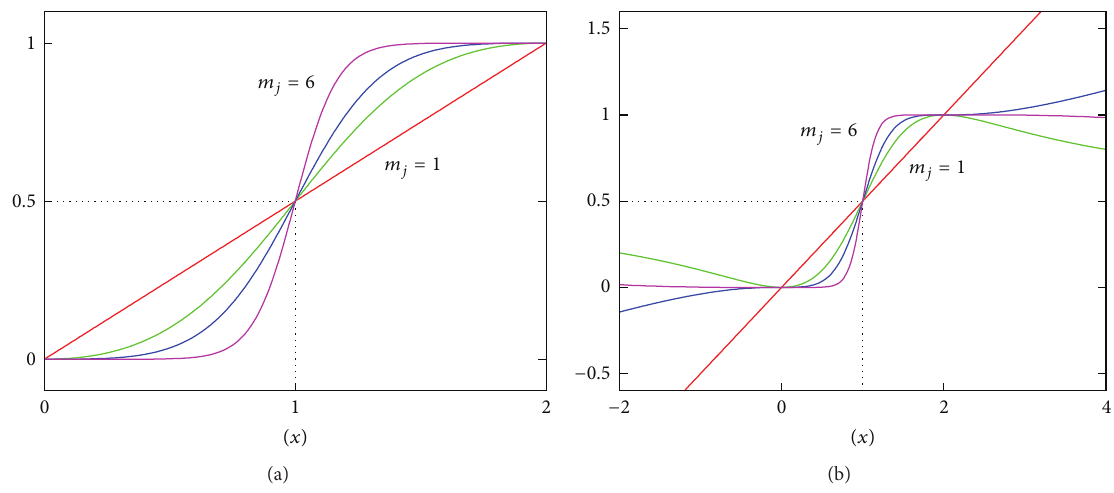
Figure 1: Graphs of the functions V 𝑗,𝑘 (𝑥) with 𝑎 𝑘 = 0 and 𝑏 𝑘 = 2 for each 𝑚 𝑗 = 1 , 2 , 3 , 6 on a subinterval [𝑎 𝑘 , 𝑏 𝑘 ] = [0, 2] in (a) and those on the whole interval [𝑎, 𝑏] = [− 2 , 4 ] in